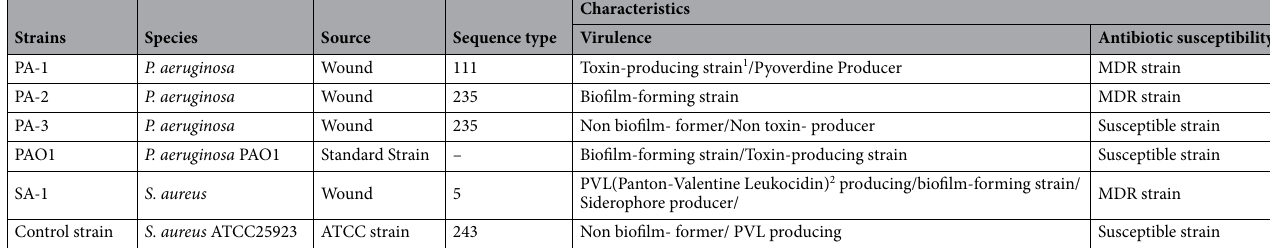
Table 3. Strains used in this study. 1 Toxin-producing strain: Strains which produced at least 3 toxins of Secretion systems I, II, and III. 2 Panton-Valentine Leukocidin (PVL) is a membrane-targeting toxin of virulent strains of S.